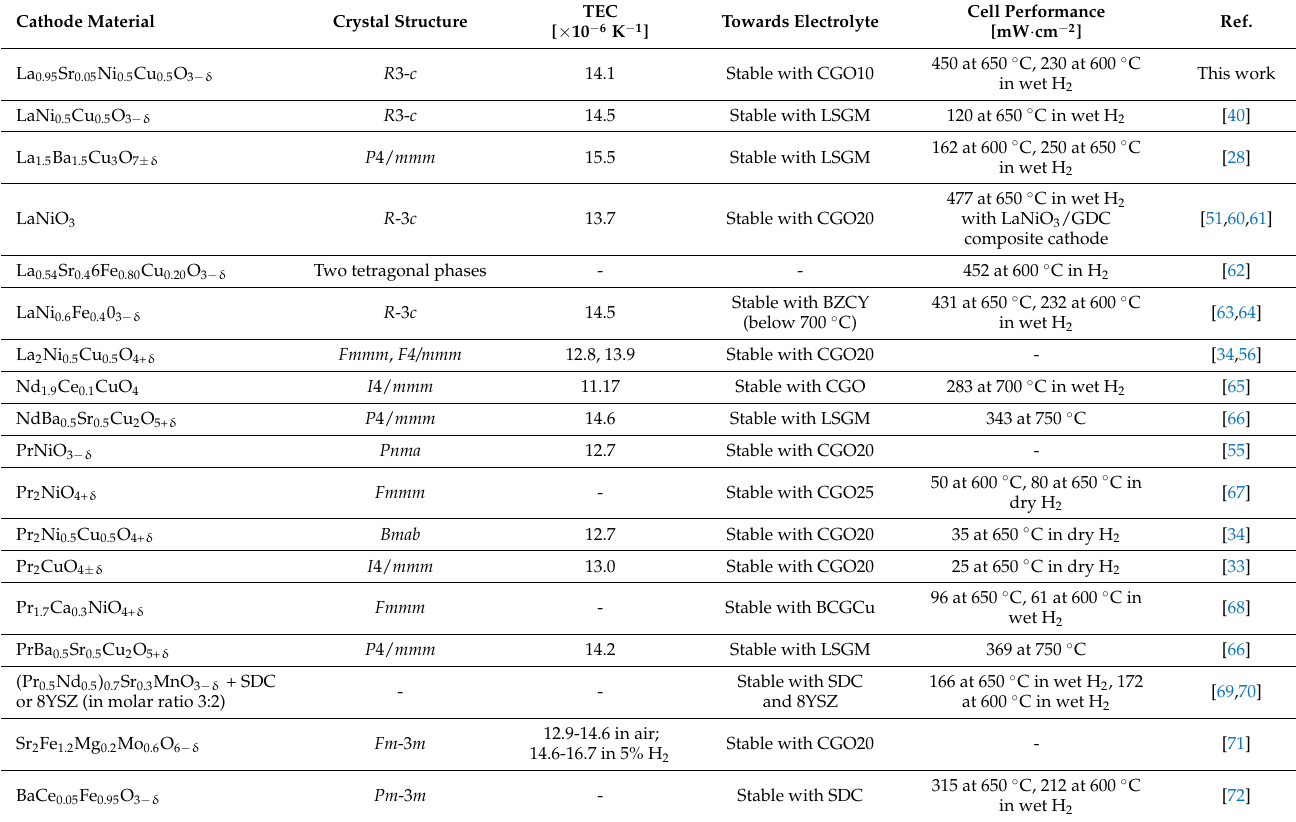
Table 5. The crystal structure, thermal expansion coefficient, compatibility with electrolytes, and SOFC performance with selected cathode